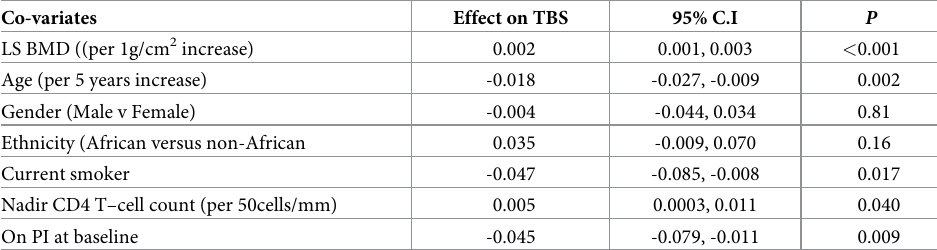
Table 3 Legend : HIV-related variables were added stepwise with predictors of TBS included in the subsequent steps in building the final model; this represents the final model which best predicts lower TBS in